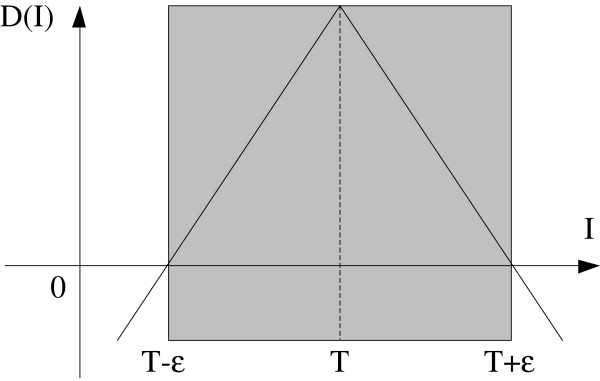
A linear speed function based on image intensity. It causes the model to expand over regions with grayscale values within the specified (positive) range and contract otherwise.